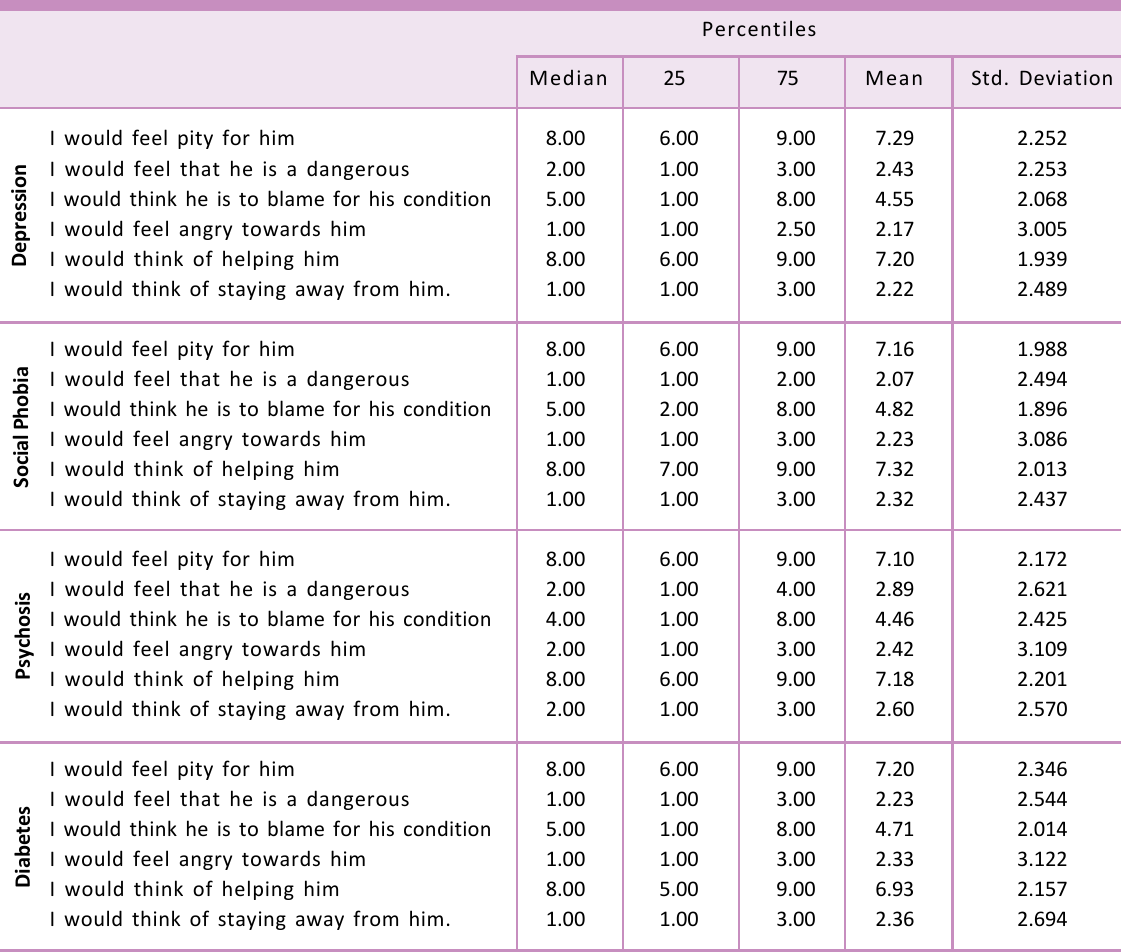
Table 1. Median and mean scores for the stigma related attributes (pity, dangerousness, blame, anger, help and staying away) between the 4 case vignettes (Scores towards 1 indicate strong disagreement, and towards 9 indicate strong